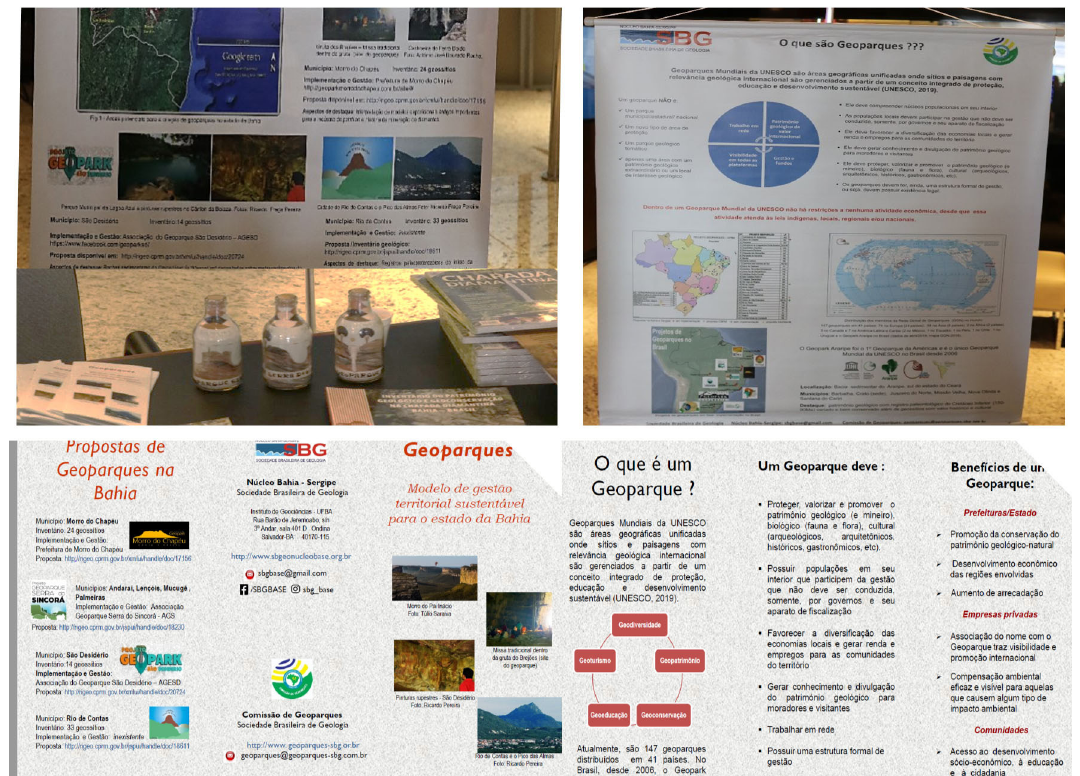
FIGURE 3. Exhibition with explanatory banners on geoparks, geoproducts (colored sand bottles), and free distribution of explanatory leaflets, tourist itineraries of Chapada Diamantina, and publications from the Bahia-Sergipe Branch on geosites and proposals for geoparks in the State of